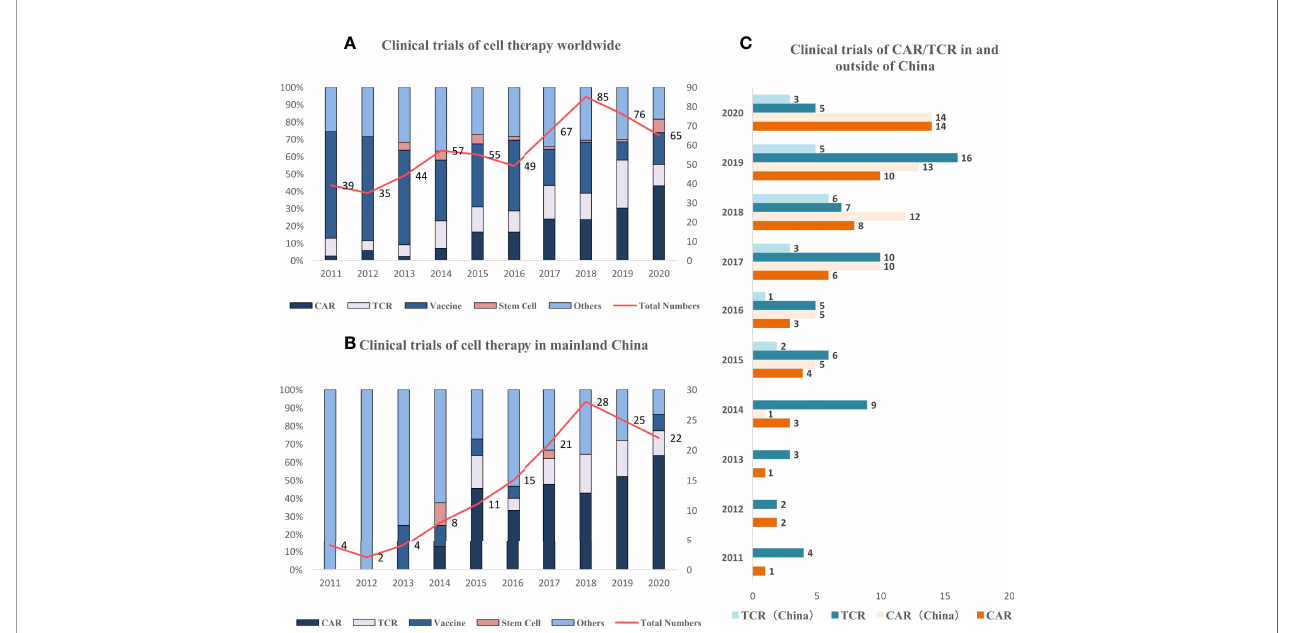
FIGURE 2 | Trend of clinical trials on cell therapy worldwide and in China. (A) Newly initiated active clinical trials on cell therapy have increased especially after 2014, and the dominating type is converting from vaccine to CAR/TCR-T. (B) Newly initiated active clinical trials in China continue to increase since 2015, and the dominating type is CAR/TCR. (C) Newly initiated active clinical trials increase both in and outside of China (since